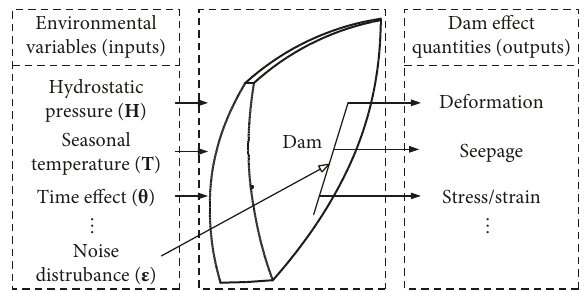
Figure 2: Dam safety monitoring system.